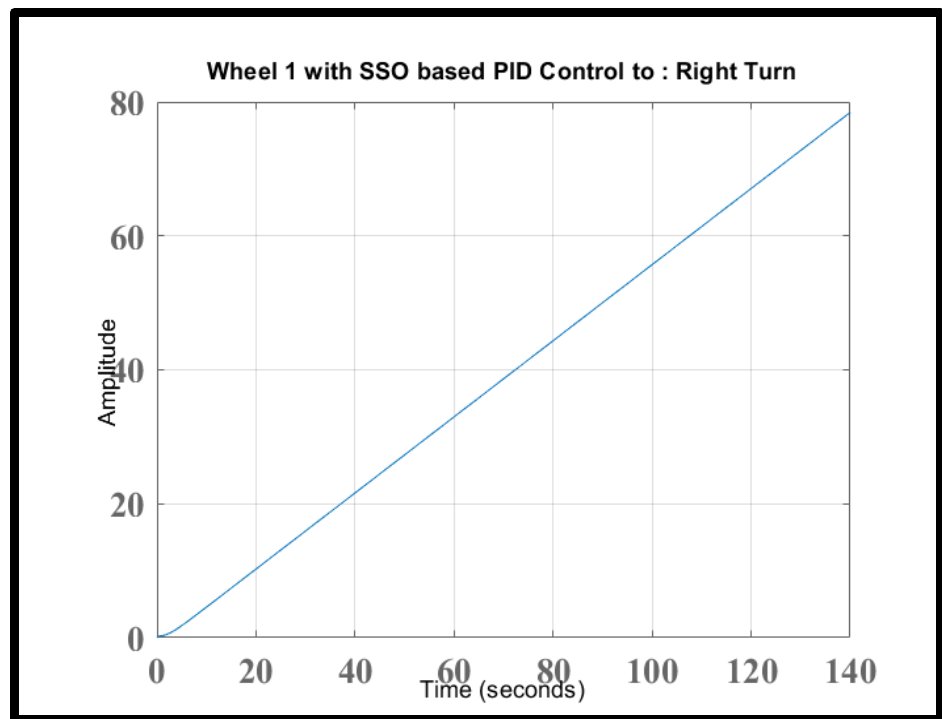
Figure 12. Simulation of wheel 2 moving forward when V r = − V L . Case 3: The robot turns towards right when V r > V L . If the velocity of the right wheel is greater than the left wheel then the robot turns right. Below Figures 13 and 14 show the simulation of the robot turning right. While turning right the robot velocity will be 2.016 m/s and the angular velocity will be 80.64 m/s.